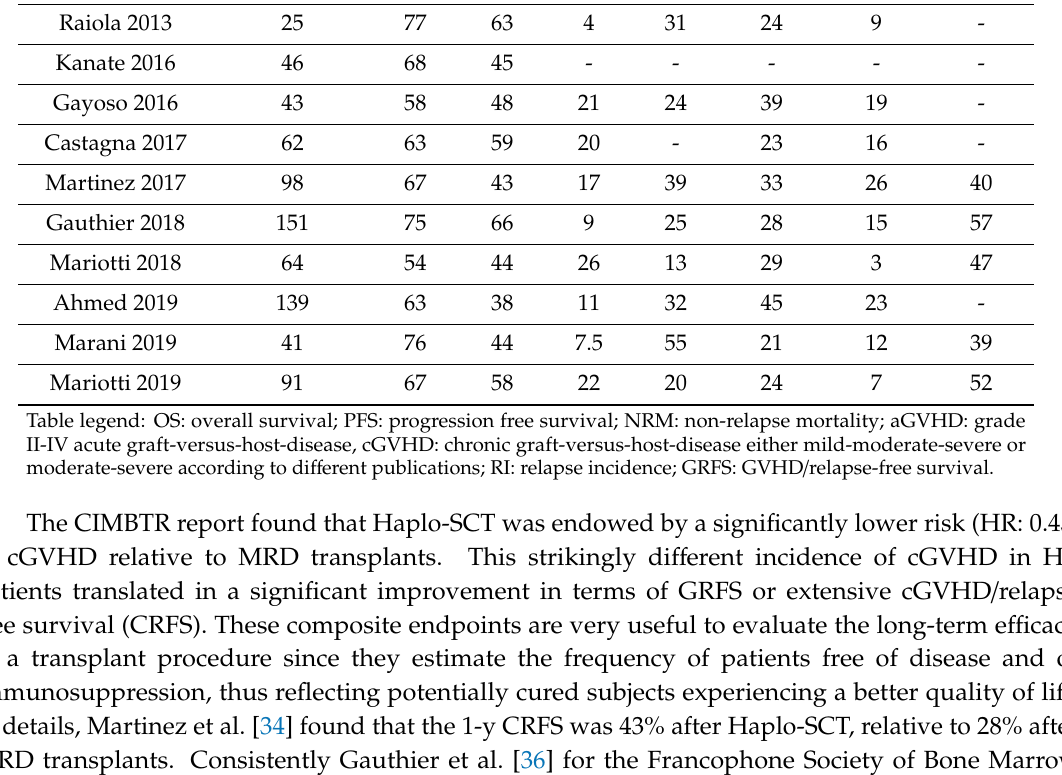
Table 2. Results from main studies employing the Haplo-SCT with PT-Cy platform for patients with R / R HL.